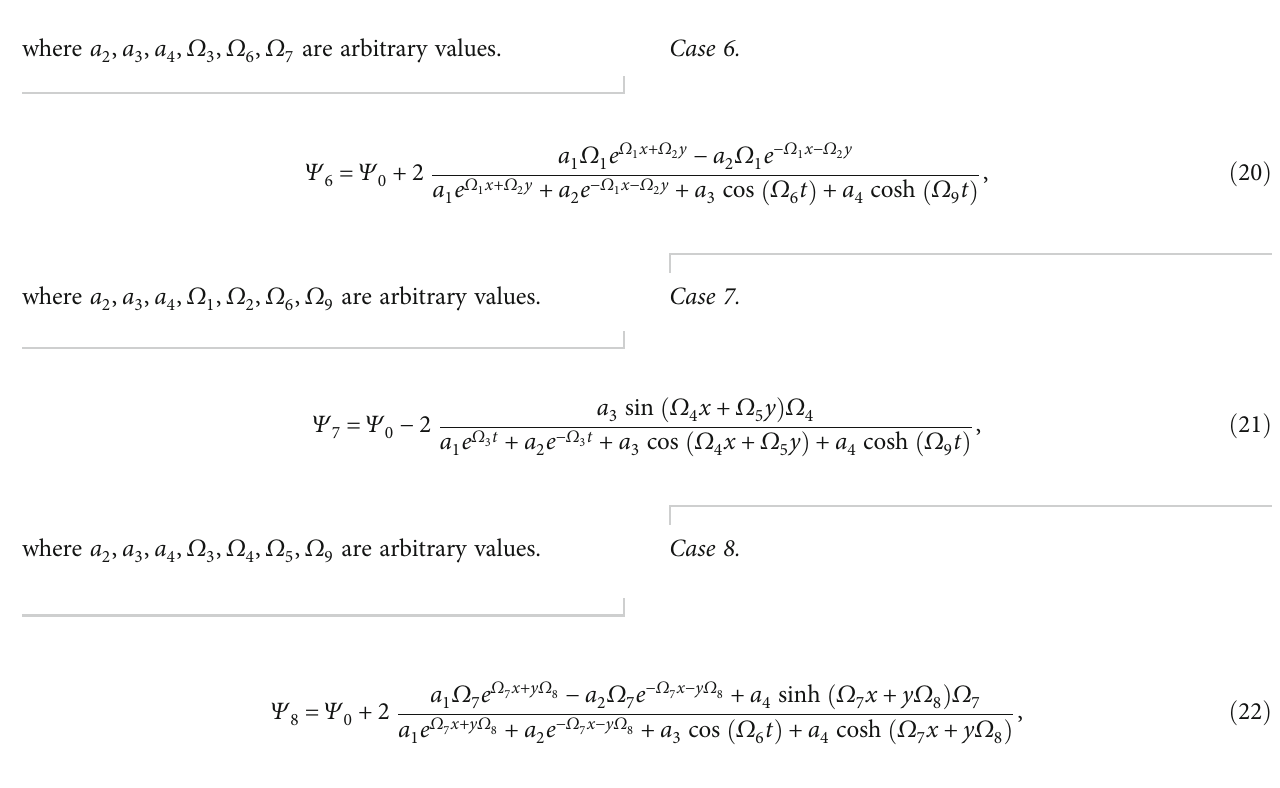
Figure 2: Plot evolution of periodic waves (14) utilizing values a = 2, δ = 1 : 3, δ = 2, Ψ = 1, t = 10 and (a) 3D plot, (b) density plot, and (c) contour 4 5 0